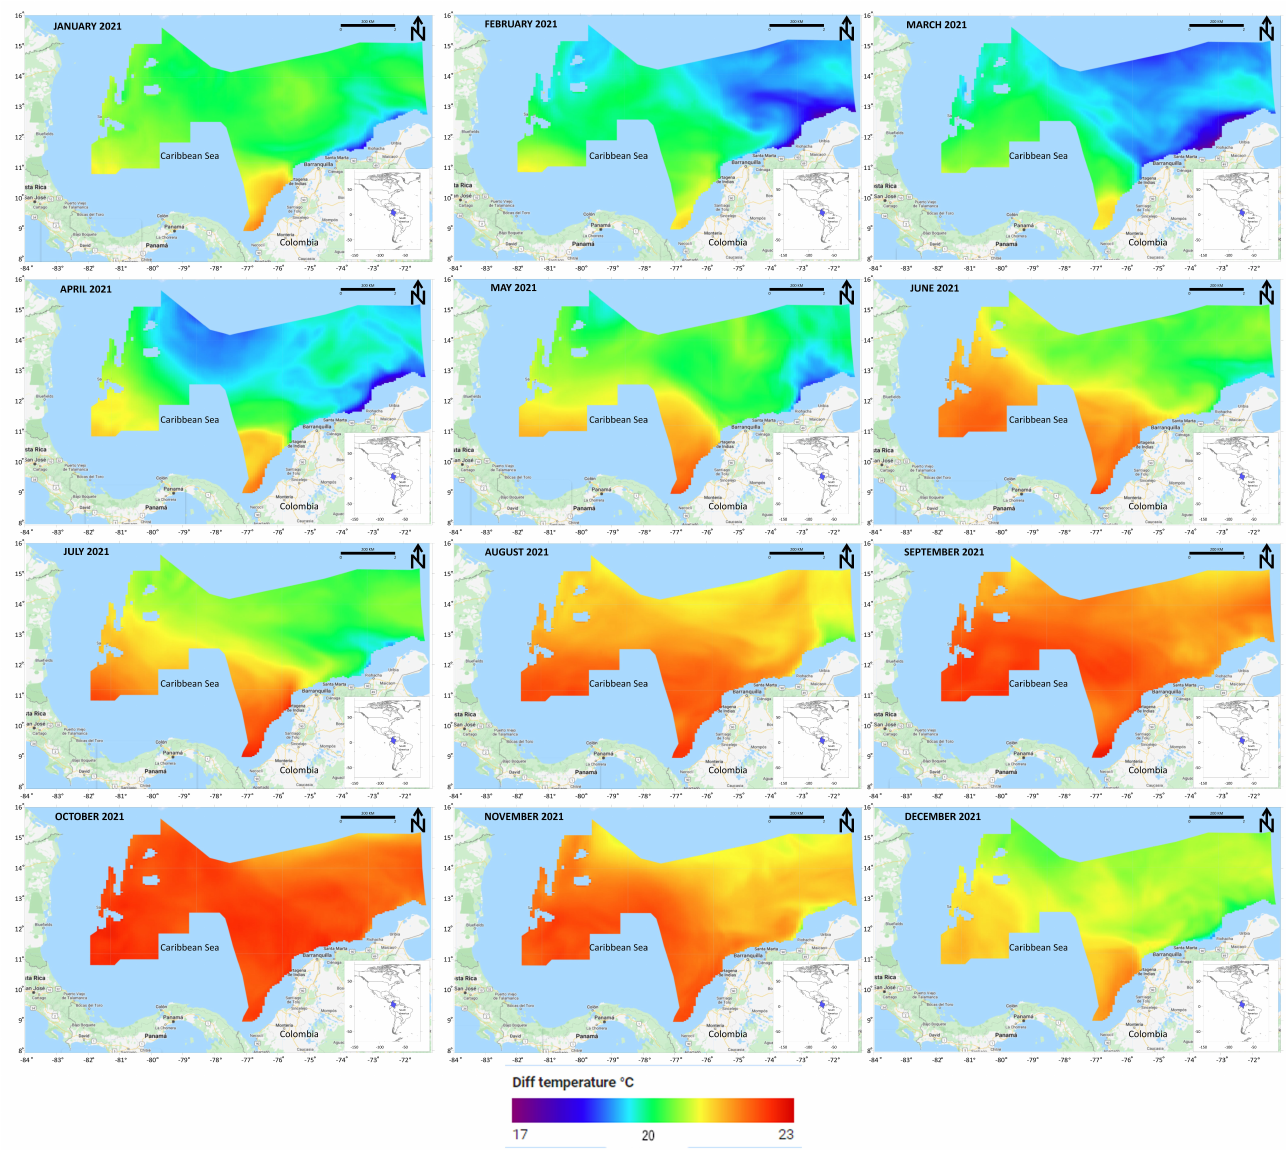
Figure 1. Temperature difference in the Colombian Caribbean throughout